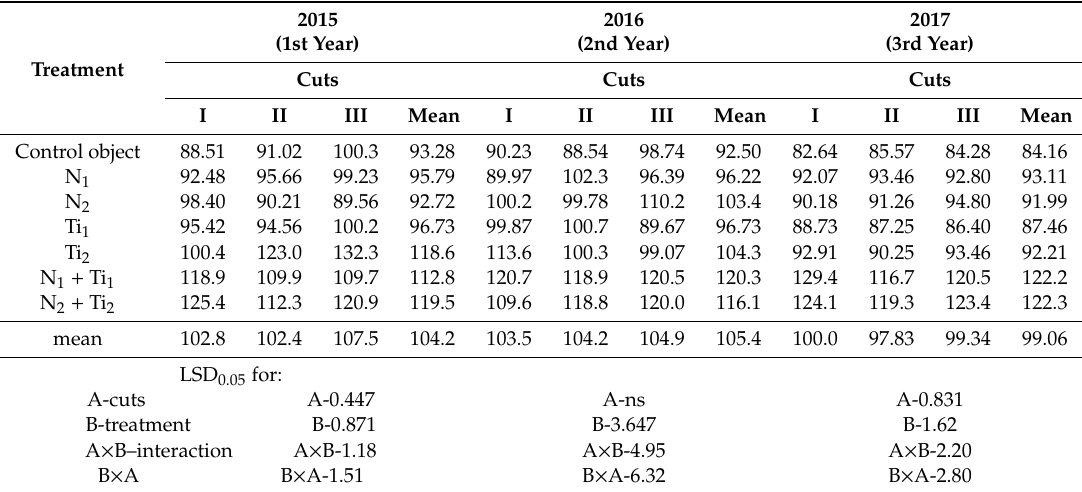
Table 4. The content of soluble sugars in Festulolium braunii (g kg − 1 DM).